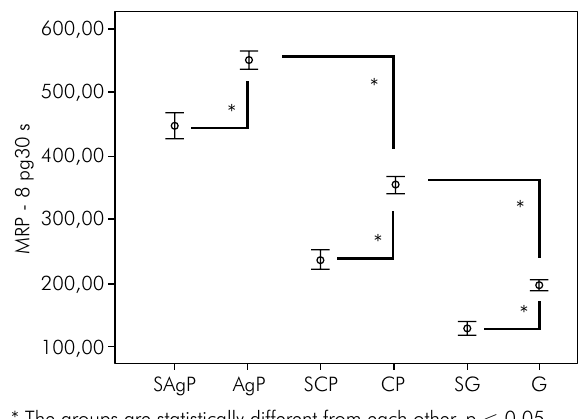
Figure 1. The comparison of the myeloid-related protein-8 (MRP-8) total levels of patients diagnosed with generalized aggressive periodontitis (SAgP) with smoking, chronic periodontitis (SCP) with smoking, gingivitis (SG) with smoking, generalized aggressive periodontitis (AgP) without smoking, chronic periodontitis (CP) without smoking, and gingivitis (G) without